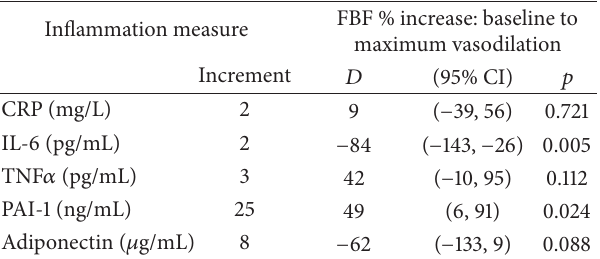
Table 6:Association oftheinflammation measureswith endothelial function (FBF % increase from baseline to maximum vasodilation). FBF % increase: baseline Inflammation measure